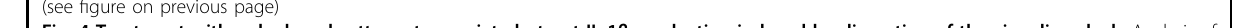
Fig. 4 Treatment with polyphenols attenuates anxiety but not IL-1 β production induced by disruption of the circadian clock. Analysis of behavior of wild-type and Bmal1 -/- mice tested in the dark-light box and elevated plus maze task. ( A ) Timeline of behavioral studies. ( B-D ) Time spent in the light zone ( B ), Entries into the light zone ( C ), and total distance traveled in the dark-light box task ( D ). ( E – G ) Time spent in the open arms ( E ), Entries into the open arms ( F ), and total distance traveled in the elevated plus maze task ( G ). N = 5 – 11 mice/group. ( H ) IL-1 β production in the hippocampus and cortex. N = 3 – 10 mice per group. ( I ) mRNA expression of the in fl ammation-related genes IL1b, Nlrp3 , and Hmgb1 in the hippocampus. ( J ) mRNA expression of the circadian clock genes Clock, Cry1 , and Nr1d1 in the hippocampus. N = 3 – 10 mice/group. ( K ) Representative fl uorescent images of CA1 hippocampal microglia. Red: Iba1. Green: Soma. Yellow: Branches. Scale bar: 15 μ m. ( L – N ) Numbers ( L ), total branch length per cell ( M ), and total branch endpoints per cell ( N ) of hippocampal microglia. N = 3 – 5 mice/group, >4 hippocampal sections studied per animal. For anatomical studies, >25 cells studied per section. * p < 0.05 , ** p < 0.01 , ***p < 0.001, ****p < 0.0001 by Two-Way ANOVA with Tukey ’ s